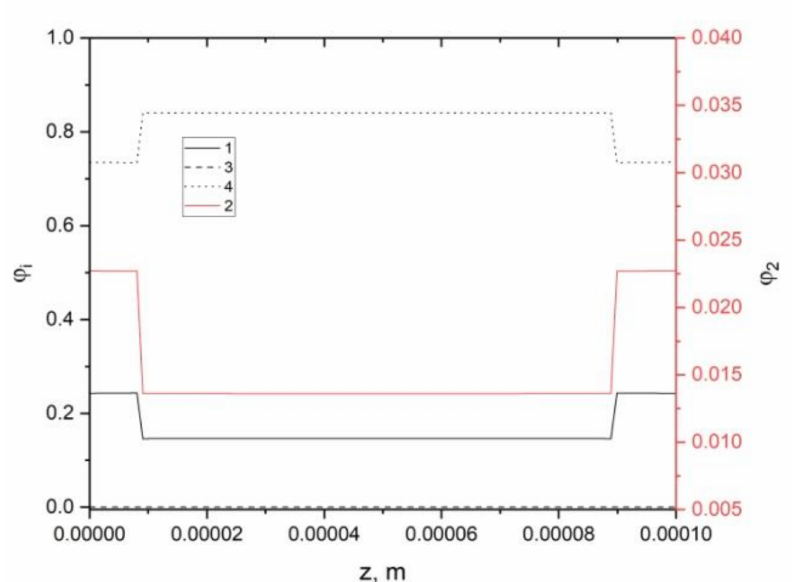
Figure 10. Distribution of volume fractions of phases under the influence of a low-intensity surface forest fire depending on the thickness of the leaf at time t = 5 s (summer, July, +20 ◦ C, ϕ 30 = 0.4, α s = 0.05): 1—dry organic matter, 2—soot particles, 3—moisture,